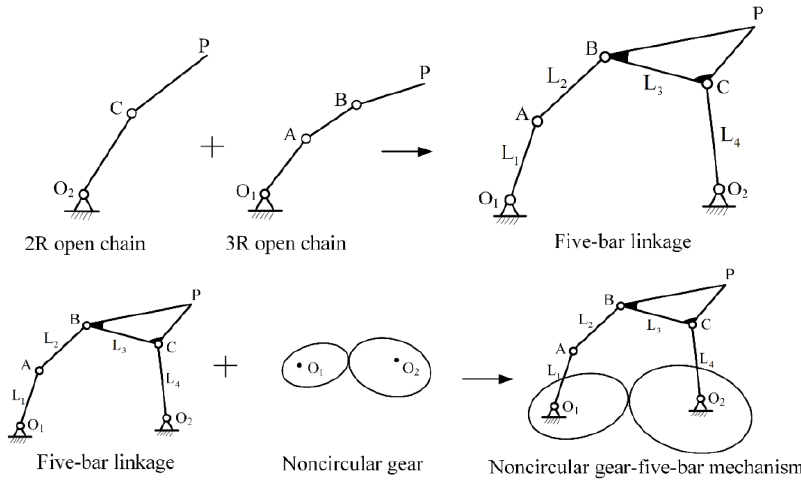
Figure 3. Schematic diagram for generating noncircular gear-five-bar mechanism.